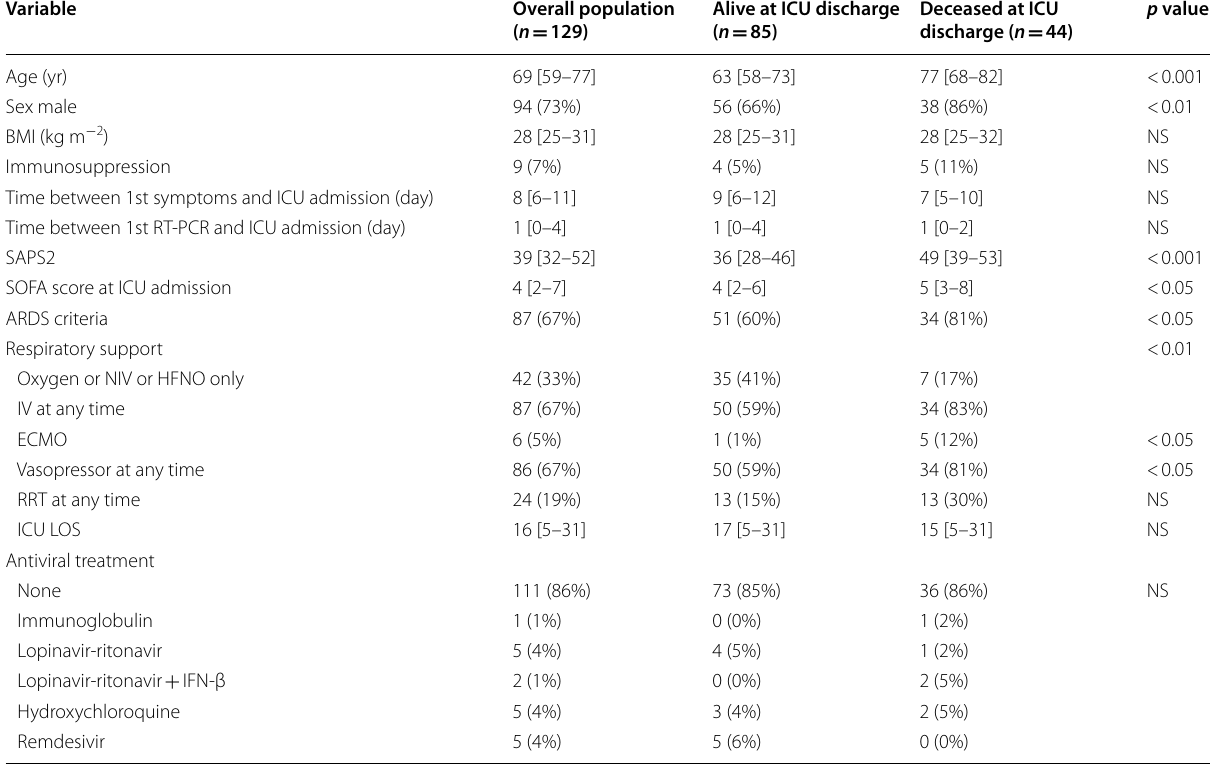
Values are median [1st quartile-3rd quartile] or count (percentage) ARDS acute respiratory distress syndrome, BMI body mass index, ECMO extracorporeal membrane oxygenation, HFNO high flow nasal oxygen, ICU intensive care unit, IFN-β interferon β, IV invasive ventilation, LOS length of stay, NS not significant, RRT renal replacement therapy, RT-PCR real-time reverse transcriptase polymerase chain reaction, SAPS2 simplified acute physiology